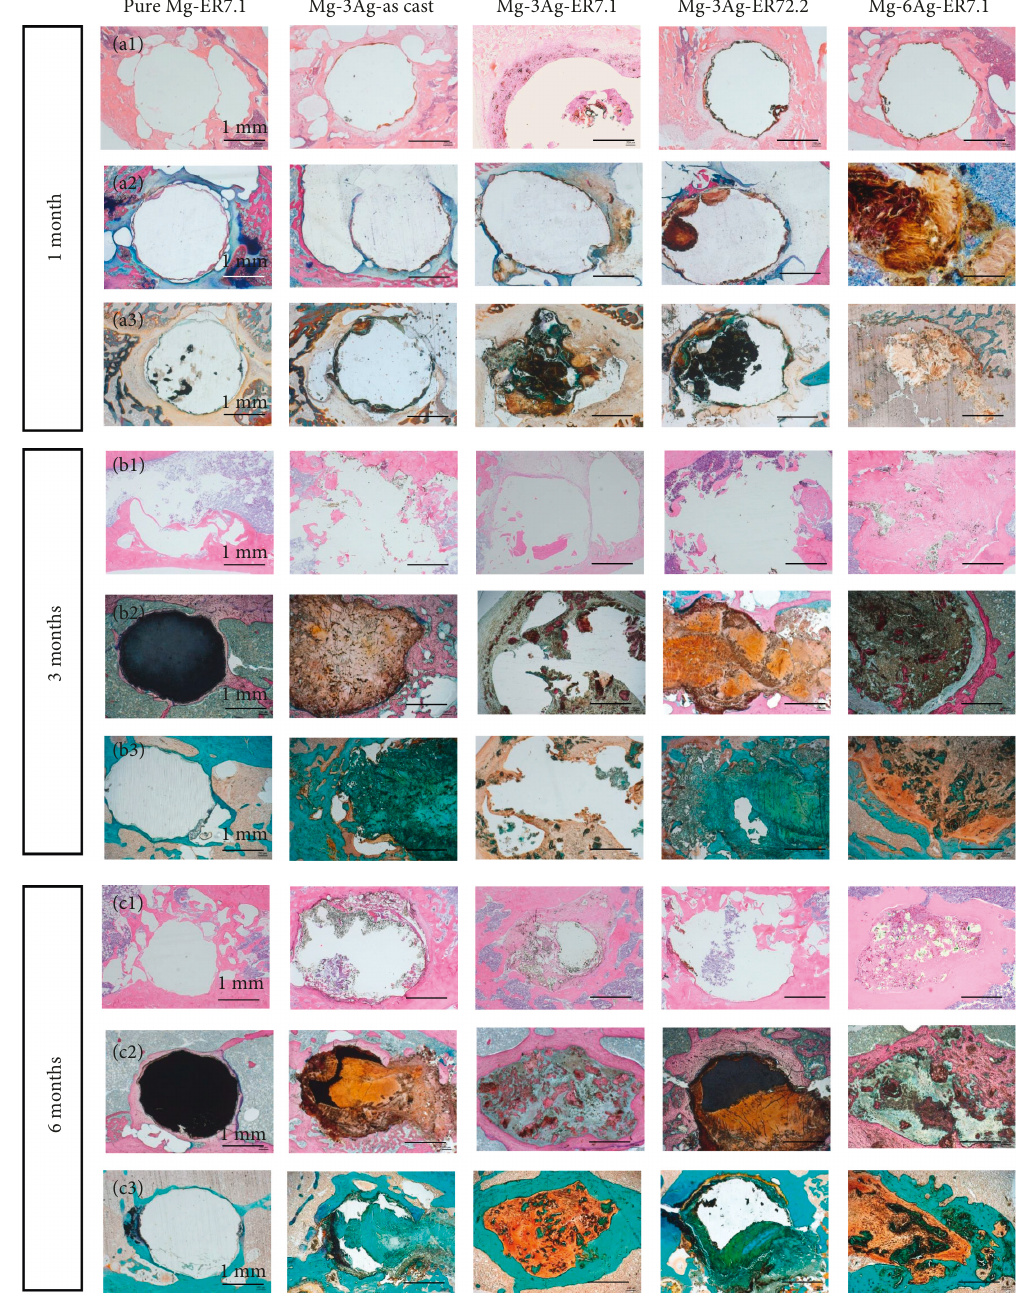
Figure 14: (a 1 , b 1 , c 1 ) Hematoxylin-eosin (H&E), (a 2 , b 2 , c 2 ) Methylene blue-acid fuchsin, and (a 3 , b 3 , c 3 ) Goldner’s trichrome stained images of the samples after 1, 3, and 6 months of